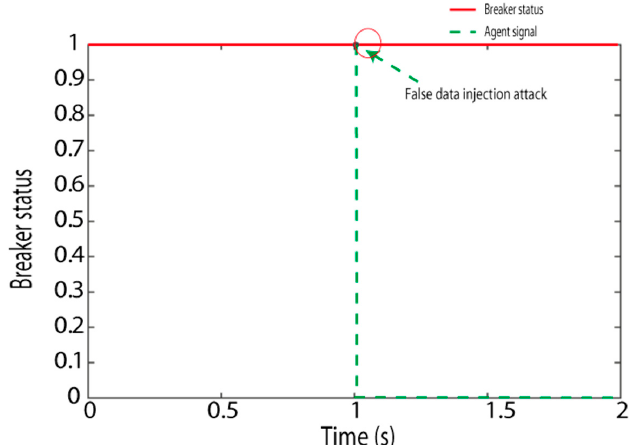
Figure 10. Responses of the system under fault and cyber-attack.